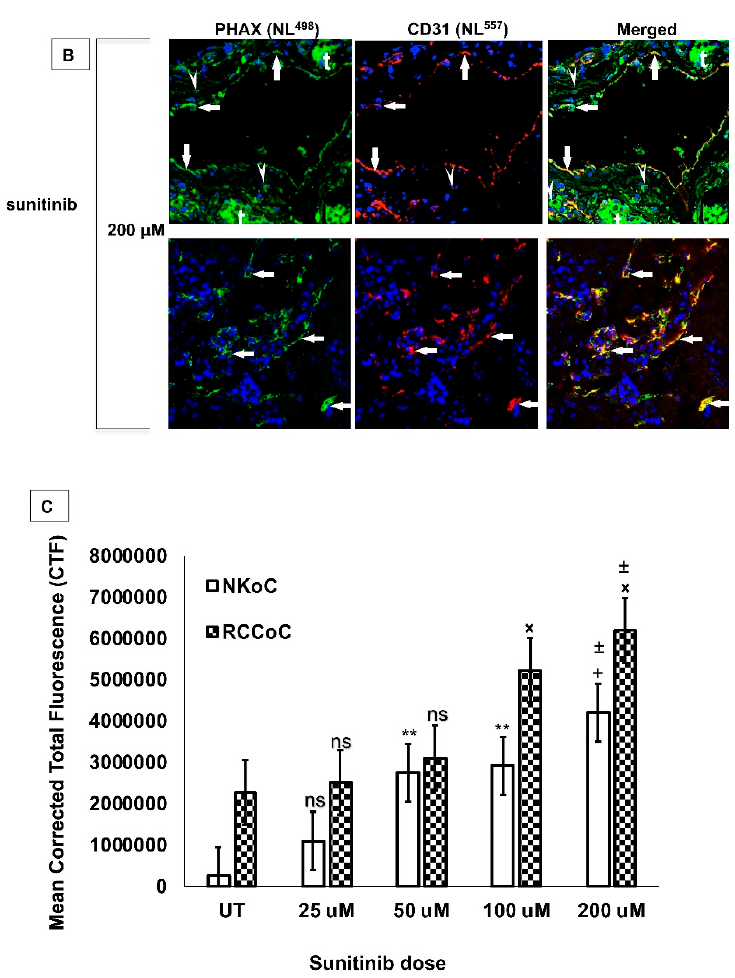
Figure 3. Representative confocal images of PHAX protein expression in organ cultures of ccRCC either untreated or treated with various doses of sunitinib for 1 h in 37 °C. ( A ). Untreated (UT) cultures of ccRCC show a mild and infrequent expression for PHAX is some tumour cells, positive for cytokeratin (CK) ( shaded arrows ). Staining intensity is increased in cultures treated with 25 and 50 µM sunitinib, greatly pronounced in cultures treated with high dose sunitinib (100 or 200 µM). Some infiltrating mononuclear cells within the interstitium are PHAX -positive and CK -negative ( open arrows ), and some CK -positive tumour cells are PHAX -negative . ( B ) Parallel sections of 200µM sunitinib-treated ccRCC organ cultures co-stained with antibody to CD31 and PHAX show a marked expression of PHAX in in CD31 positive endothelial cells ( arrows ), in some infiltrating cells ( arrowheads ), and in CD31 negative tumour cells ( t ). Original magnification ×40. ( C ). Quantification of mean fluorescence intensity calculated as corrected total fluorescence (CTF = integrated density—(area of selected cell × mean fluorescence of background readings) for PHAX/CK co-expression in tumour cells (NK organ cultures (NKoC)—** P < 0.05—UT vs. 50 or 100 µM; + P < 0.01—UT vs. 200 µM; ± P < 0.01—100 vs. 200 µM; RCC organ cultures (RCCoC)—ns (not significant—UT vs. 25 or 50 µM; × P < 0.001—vs. UT, 25 or 50 µM; ± P < 0.05—vs. 100 µM). Bars = mean + SEM. N = 3 per group with similar results.